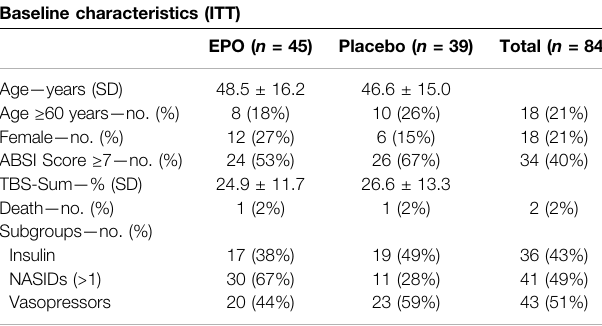
TABLE 1 | Baseline characteristics of ITT population. Baseline characteristics